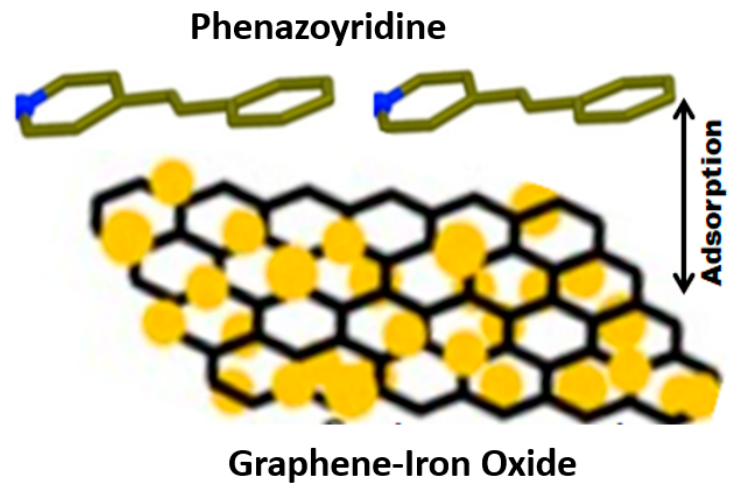
Figure 14. Adsorption of phenazopyridine residues on graphene–iron oxide.